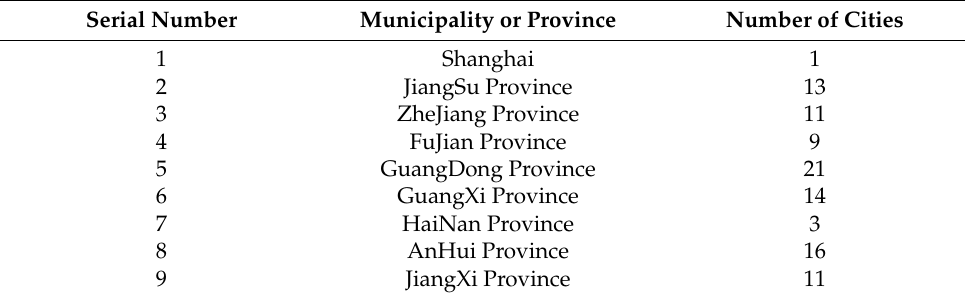
Figure 1. Study area including eight southeast provinces and Shanghai. The figure on the left shows the location of the study area and the right figure shows the location image of the study area based on NDVI . Table 1. Specific administrative units in the study area.